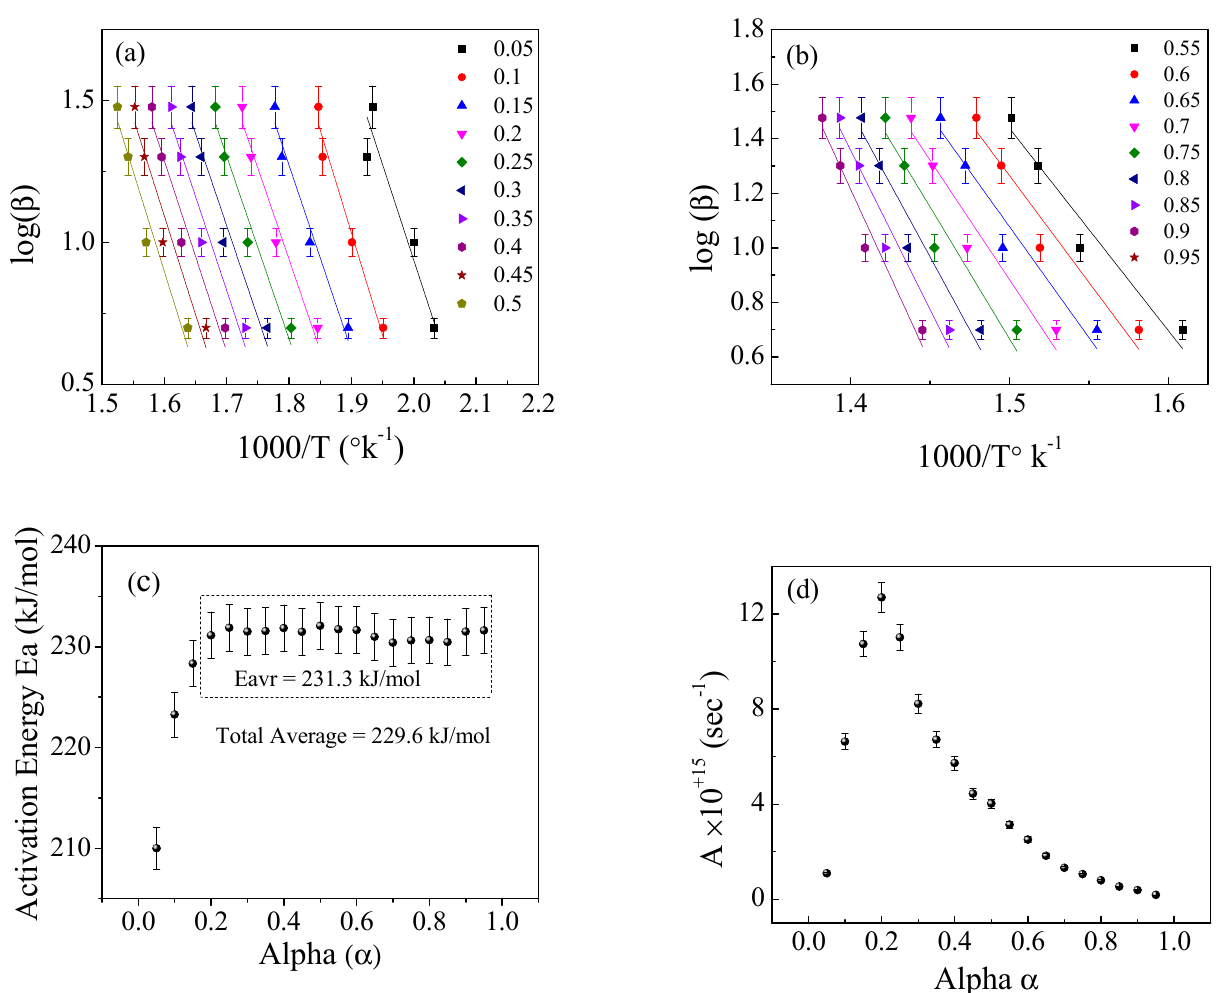
Figure 8. The Kissinger–Akahira–Sunose method for the EPDM host composite: ( a , b ) ln( β /T 2 ) ver- sus temperature; ( c , d ) the dependence of E a and A, respectively, on conversion α .